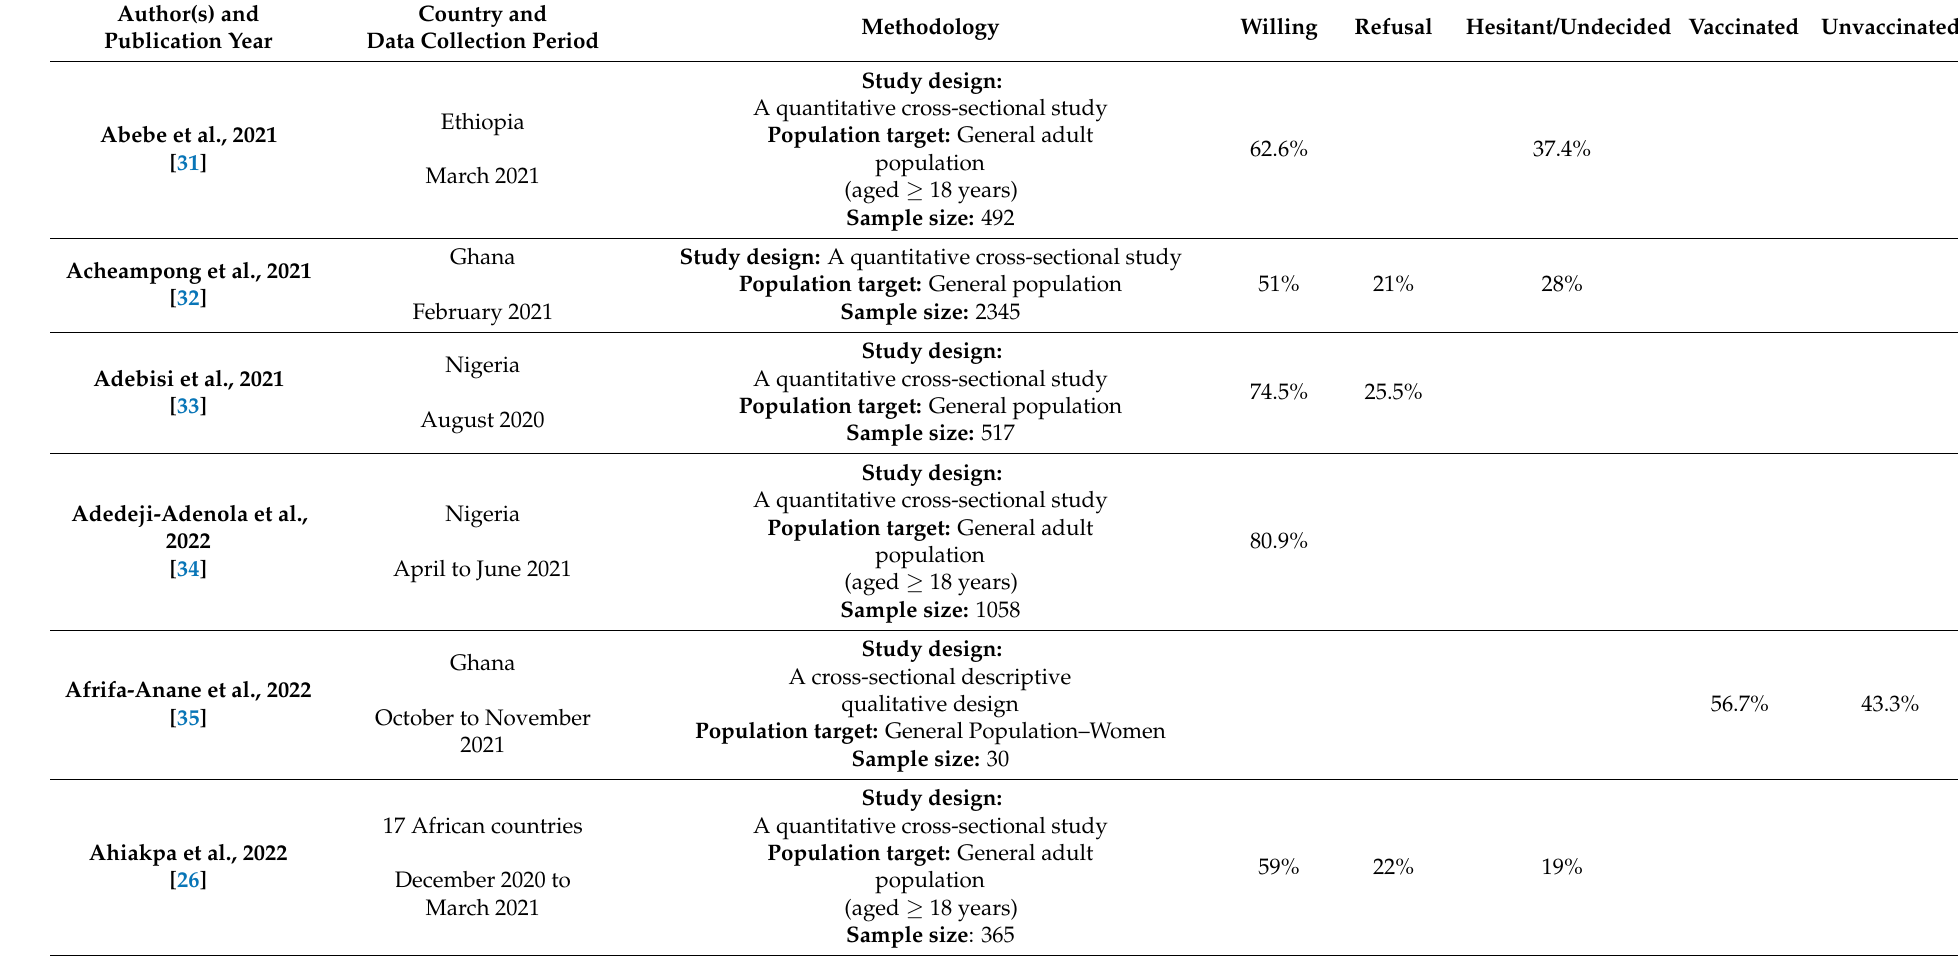
Table 2. Characteristics and vaccine acceptance and intention